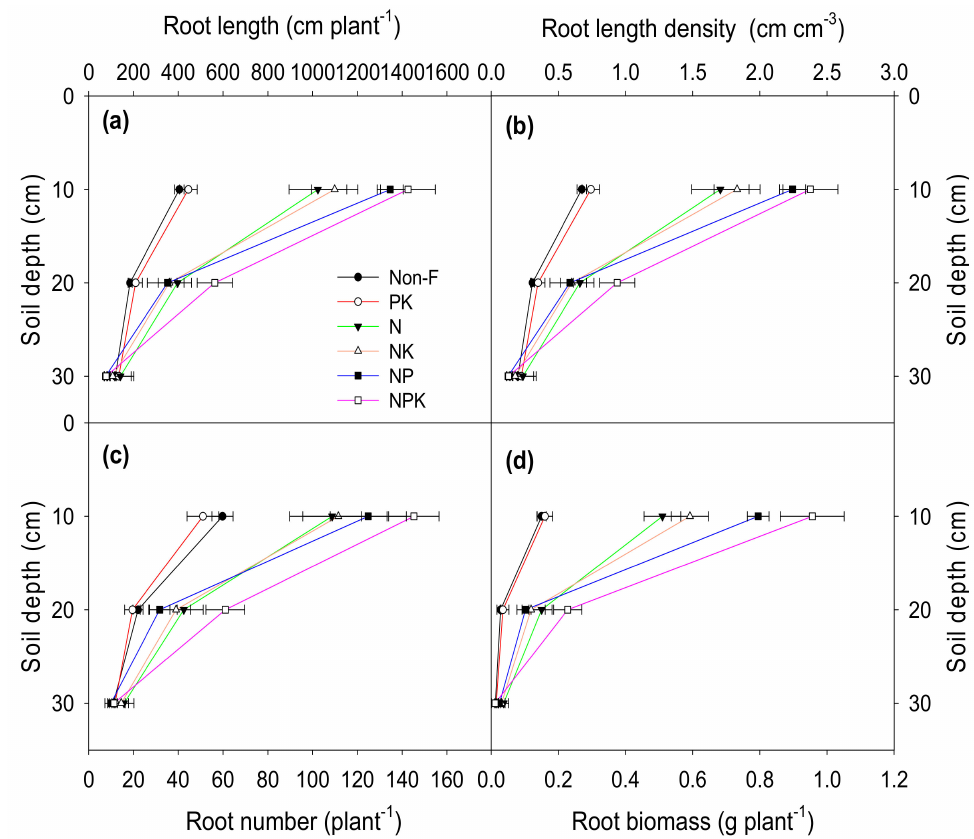
Figure 5. Destructively measured vertical profiles of total root length ( a ), root length density ( b ), root number ( c ), and root biomass ( d ) per plant up to a 30 cm soil depth at 42 d after transplanting (the root soil was divided into three 10-cm sections from the top to bottom of each rhizo-box). Vertical bars indicate ± SE ( n =